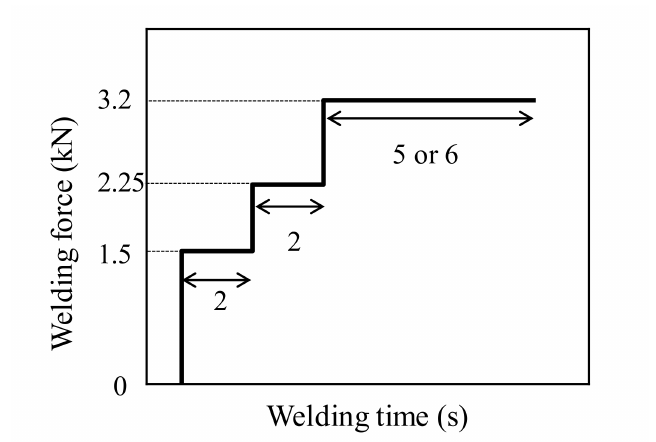
Figure 2. Relation between welding force and welding time in